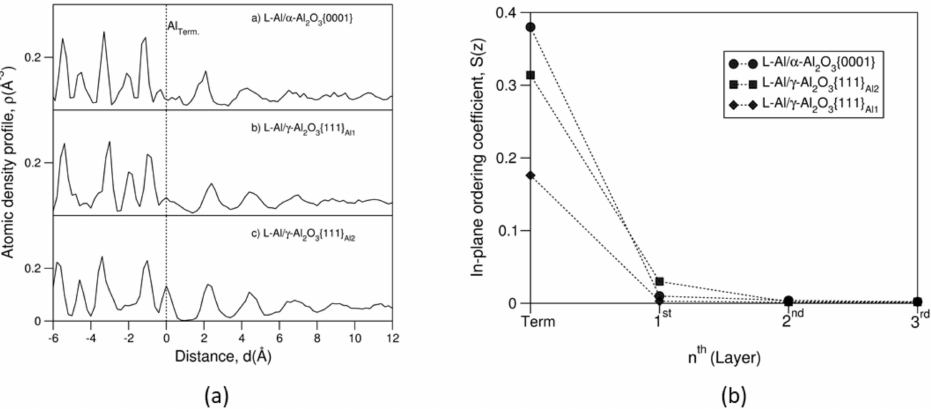
Figure 4. The Al terminating layers can be either flat or rough and atomic ordering at the Al( l )/Al 2 O 3 interfaces is overall weak. Atomic density profiles ( a ) and in-plane ordering coeffi- cient ( b ) at the equilibrated Al( l )/Al 2 O 3 interfaces [49,62]. The vertical dotted line in 4a marks the terminating Al